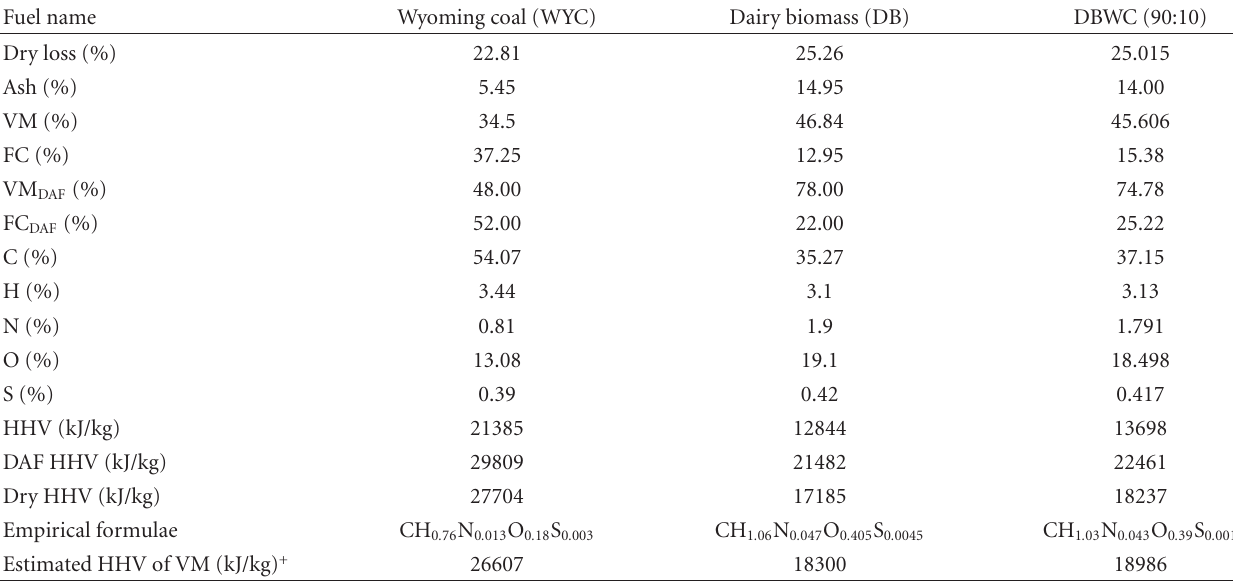
Table 1: Ultimate and proximate analysis on an as received basis.